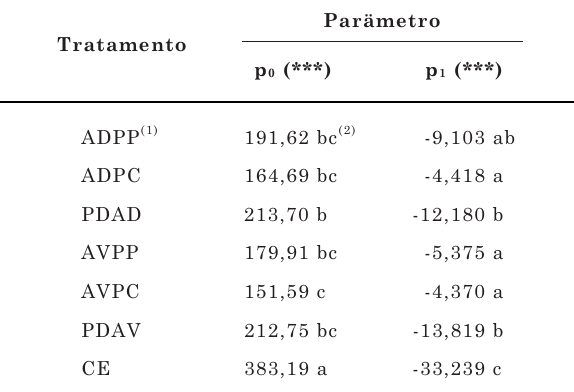
(1) Ver quadro 3 para descrição dos tratamentos. (2) Valores se- guidos da mesma letra na coluna não apresentam diferenças significativas entre si pelo teste t a 5 %. ***: Significativo a 1 % pelo teste